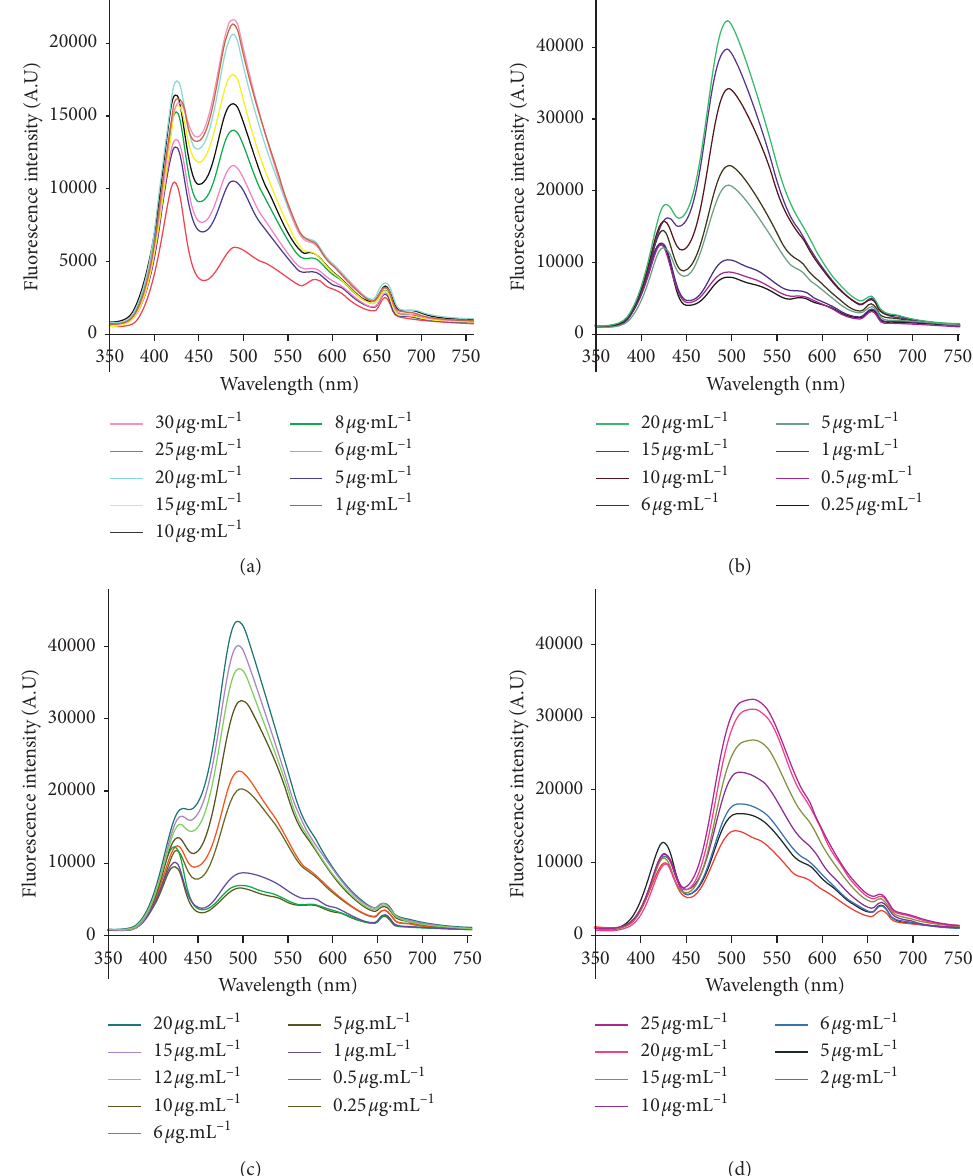
Figure 4: Fluorescence spectra of standard solutions: (a) ciprofloxacin, (b) ofloxacin, (c) levofloxacin, and (d) moxifloxacin. Condition: flow rate; 400 μ L · min − 1 ; integration time: